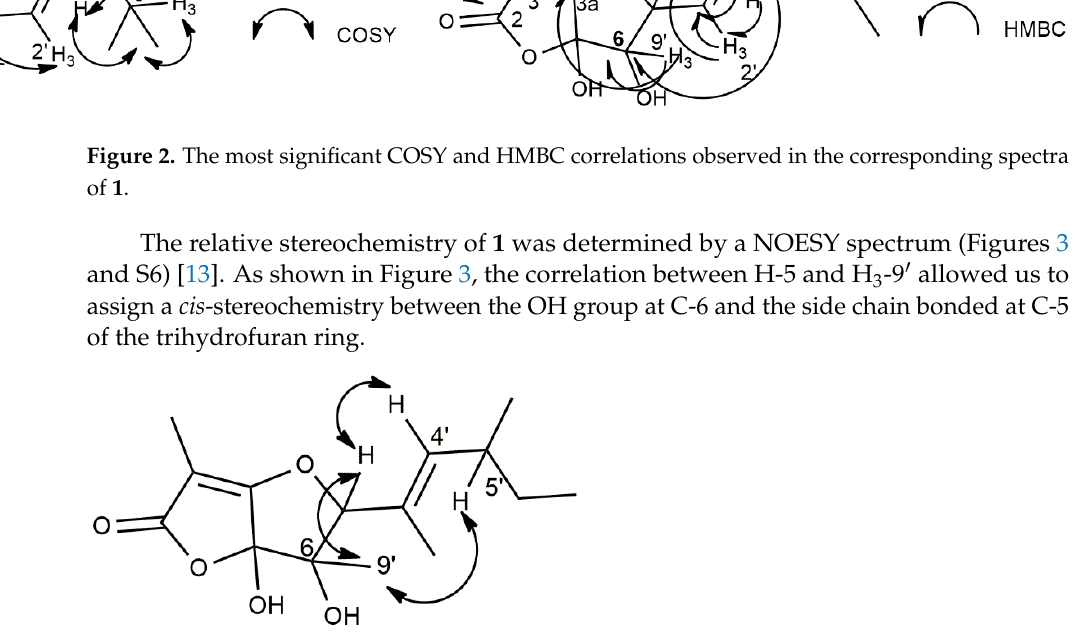
Figure 3. Significant NOE correlations observed in the NOESY spectrum of 1 .